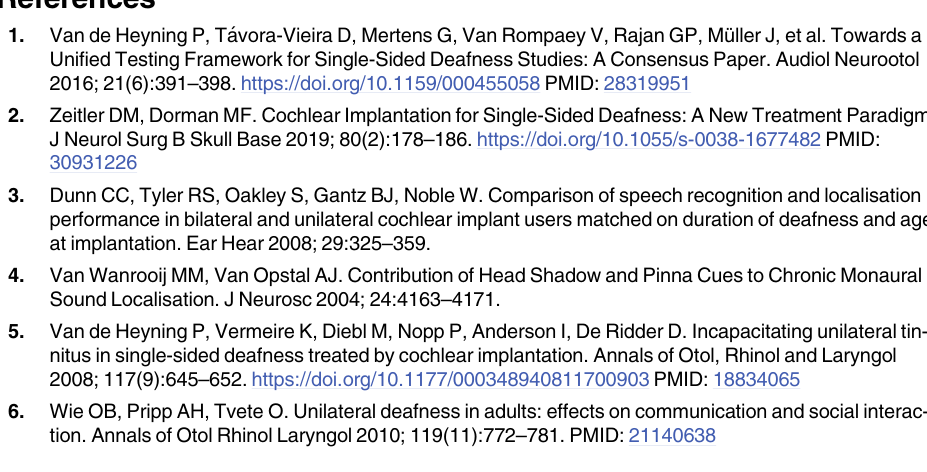
S1 Table. Patient characteristics after allocation of treatment. S2 Table. Data